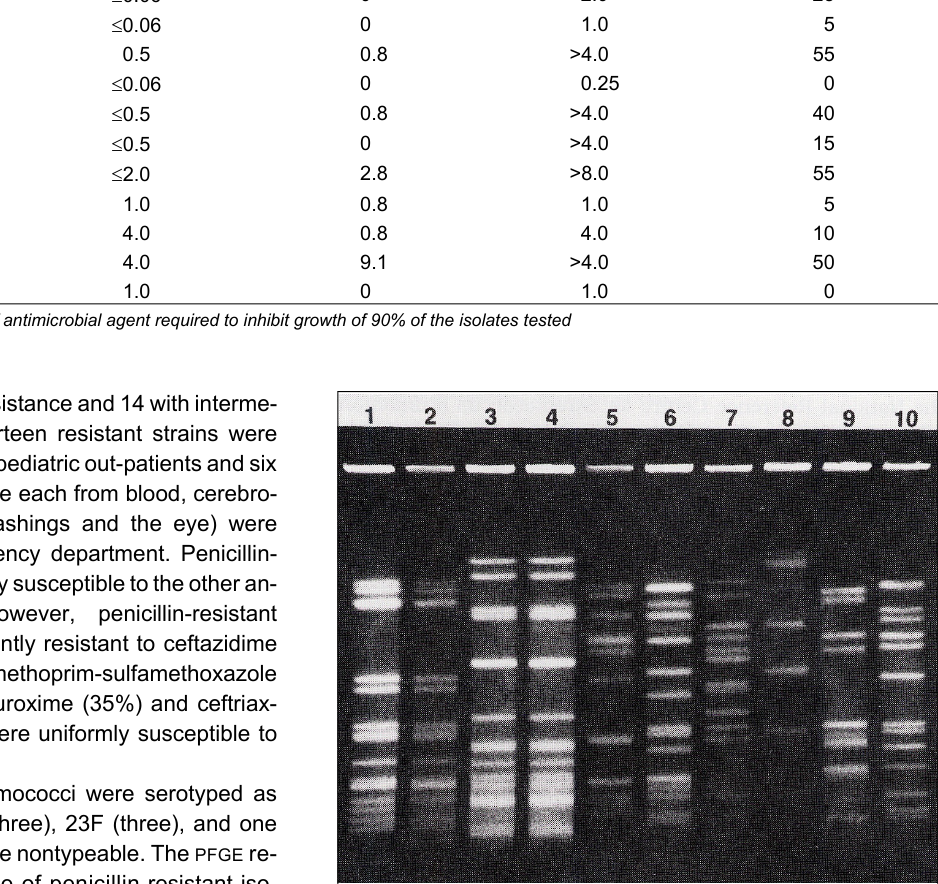
Fig ure 1) Re stric tion en do nu cle ase analy sis of ge nomic DNA of penicillin- resistant Strep to coc cus pneu mo niae iso lates ob tained by pulsed field gel elec tro pho re sis af ter di ges tion with SmaI. Lanes 1 and 2, se ro type 9V iso lates from two dif fer ent pa tients; lane 3, non type